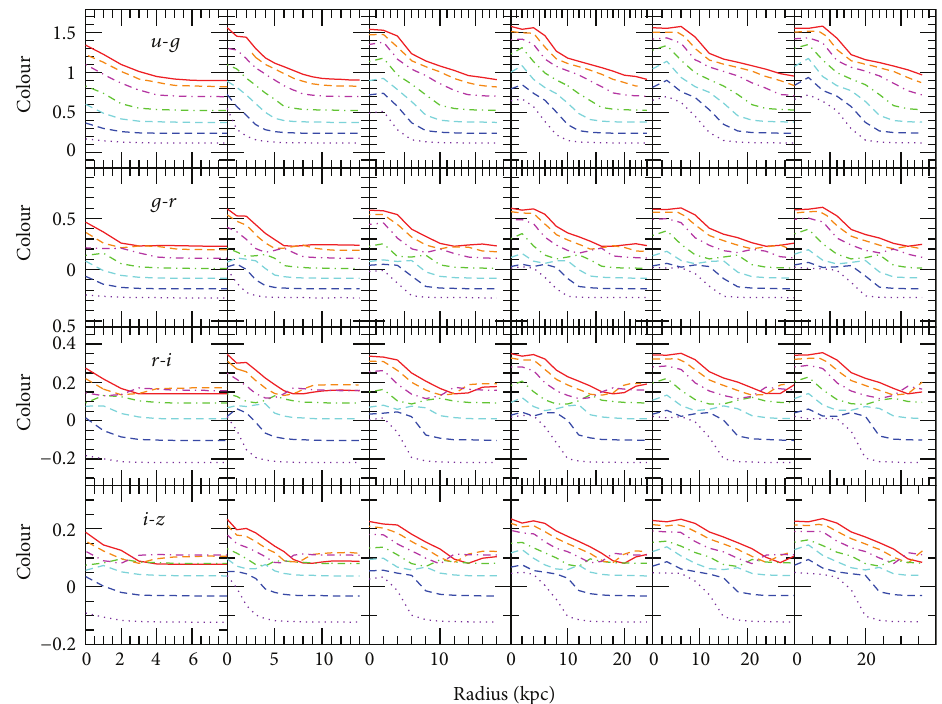
Figure 16: Evolution of colors radial profiles for 𝑢 redshift while each column is a different theoretical galaxy of Table 1, from the galaxy, with 𝑉 max = 78 kms −1 , to the most massive at the right for 𝑉 max = 290 kms −1